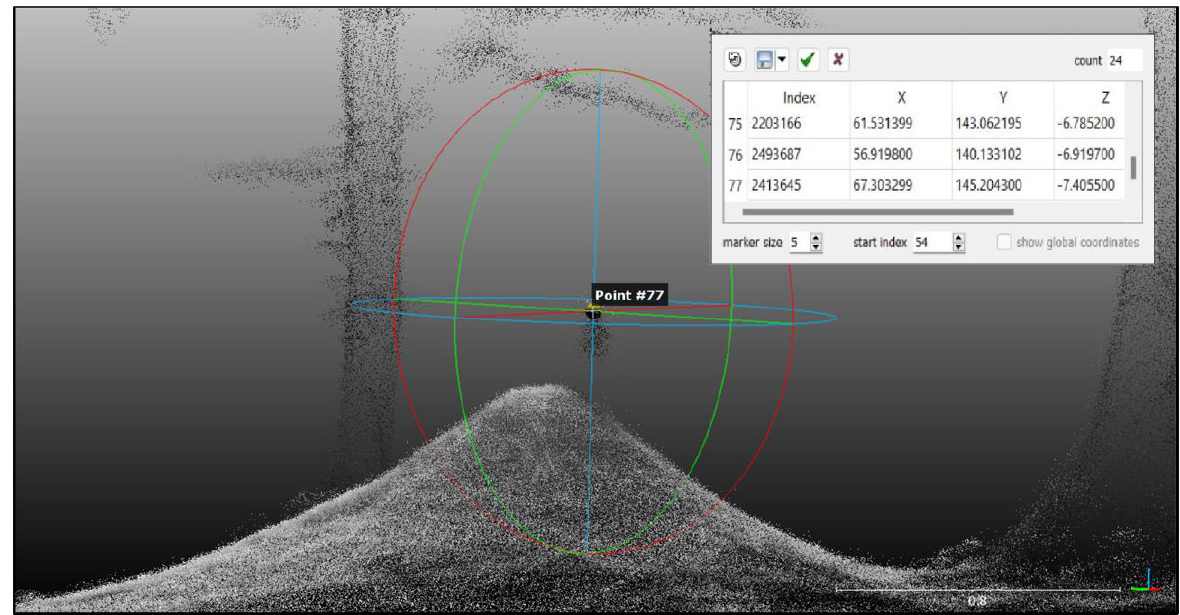
Figure 2. A nest obtained from a point cloud collected by MLS. In the center, the point at the tip of the flag placed on a nest for which the coordinates were determined in Cloud Compare (and shown in table from the upper right corner).